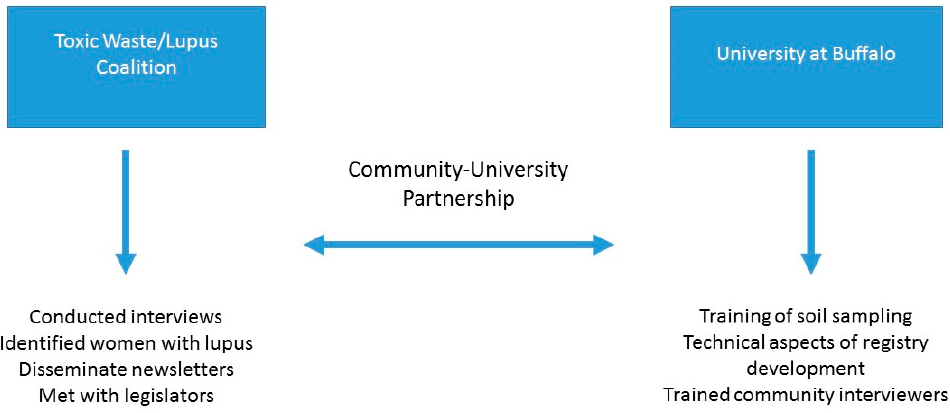
Figure 1. Details the roles and responsibilities of the Toxic Waste Coalition and the University at Buffalo.